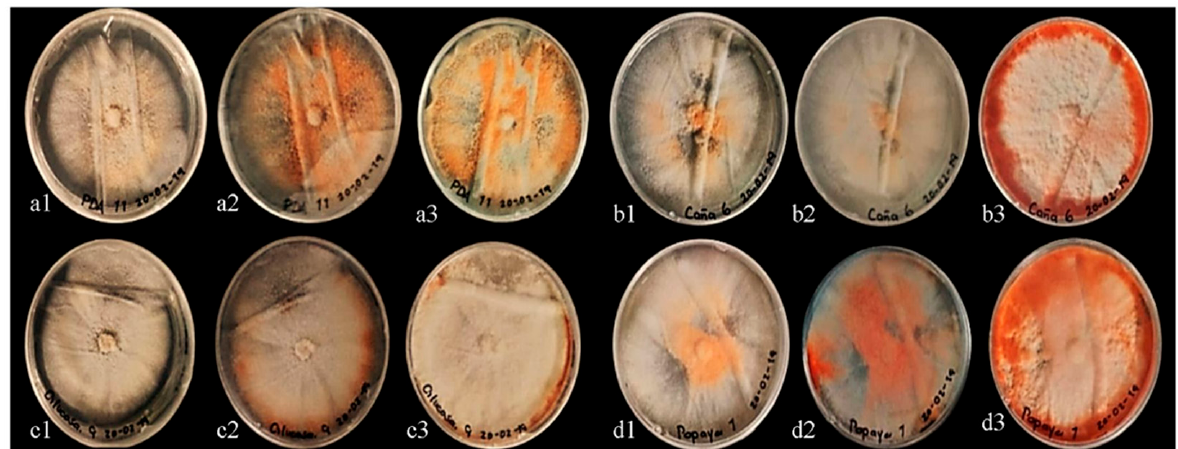
Figure 3. Development of strain CP-MaPs ( P. sanguineus ) and production of biomass: ( a1 – a3 ) = Control; ( b1 – b3 ) = PDA+C; ( c1 – c3 ) = PDA+G; ( d1 – d3 ) = PDA+P; ( a1 , b1 , c1 , d1 ) = incubation at 7 days; ( a2 , b2 , c2 , d2 ) = incubation at 14 days; ( a3 , b3 , c3 , d3 ) = incubation at 21 days.